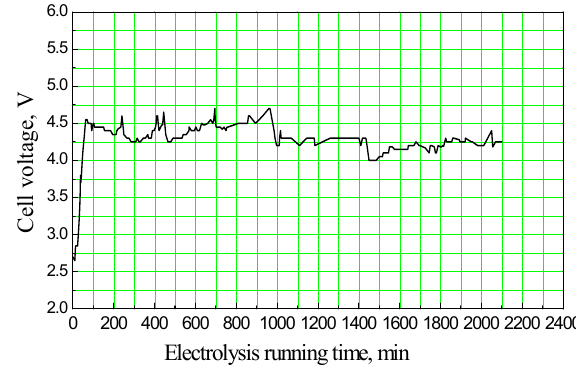
Figure 4. Plot of cell voltage vs. time during electrolysis with 51Fe-39Ni-10Al 2 O 3 anode.